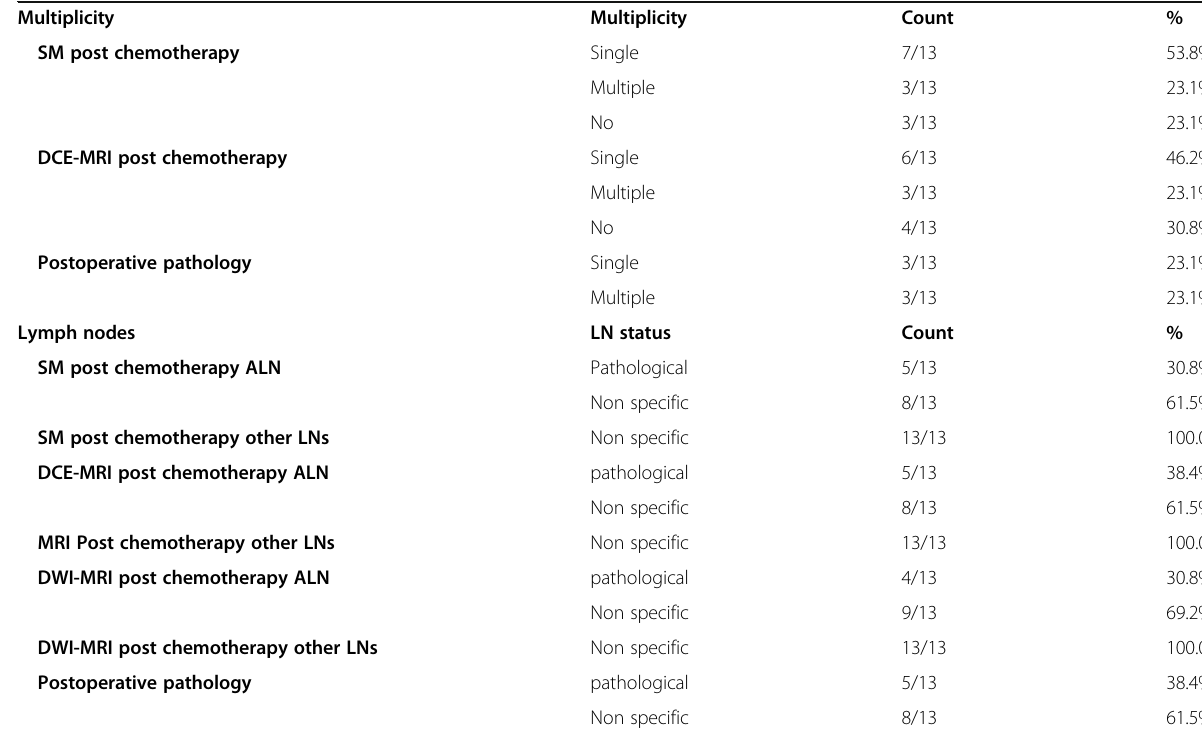
Table 6 Table showing multiplicity and axillary lymph nodes status by the different imaging modalities in neo-adjuvant group